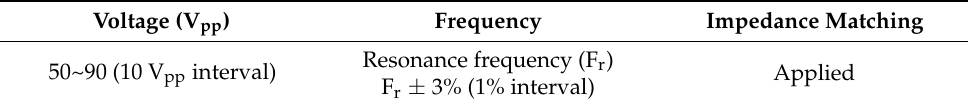
Table 1. Driving frequency and voltage conditions.